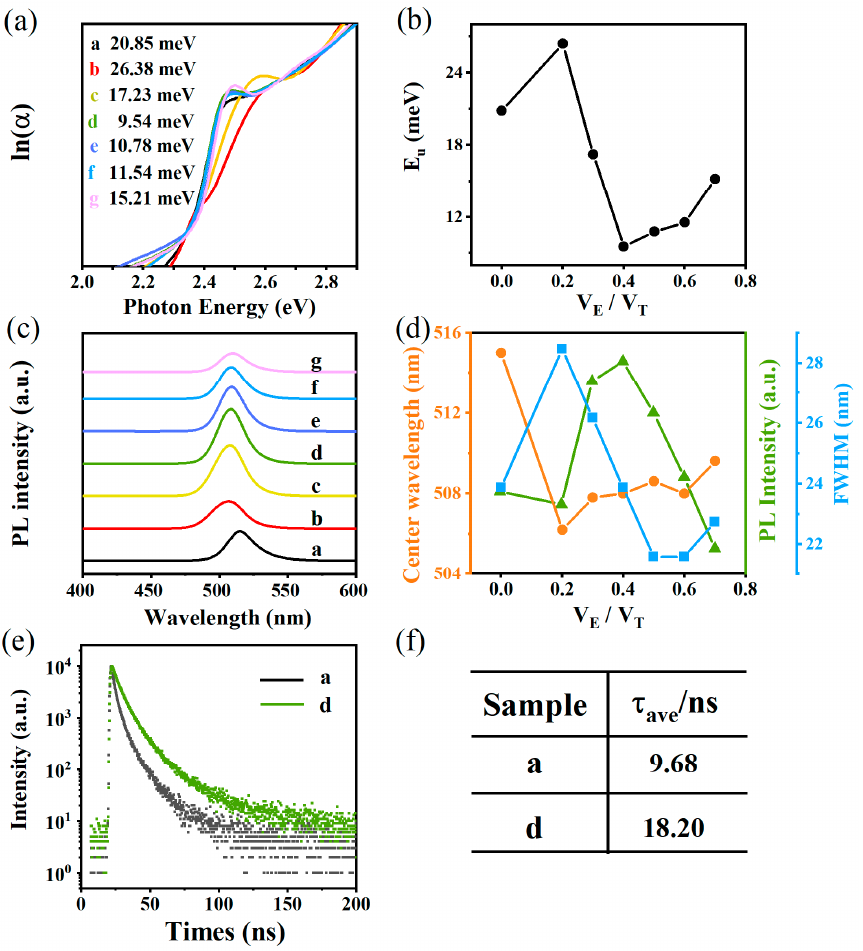
Figure 3. ( a ) Logarithmic absorption coefficient of sample a-g as a function of photon energy; ( b ) Relationship between VE/VT and Urbach energy; ( c ) Emission spectra of samples a-g excited by 365 nm; ( d ) Relationship between VE/VT and Central wavelength, PL intensity and FWHM; ( e ) PL decay for samples a and d with a 325 nm pulse laser; ( f ) The fitted average lifetime of samples a and d.